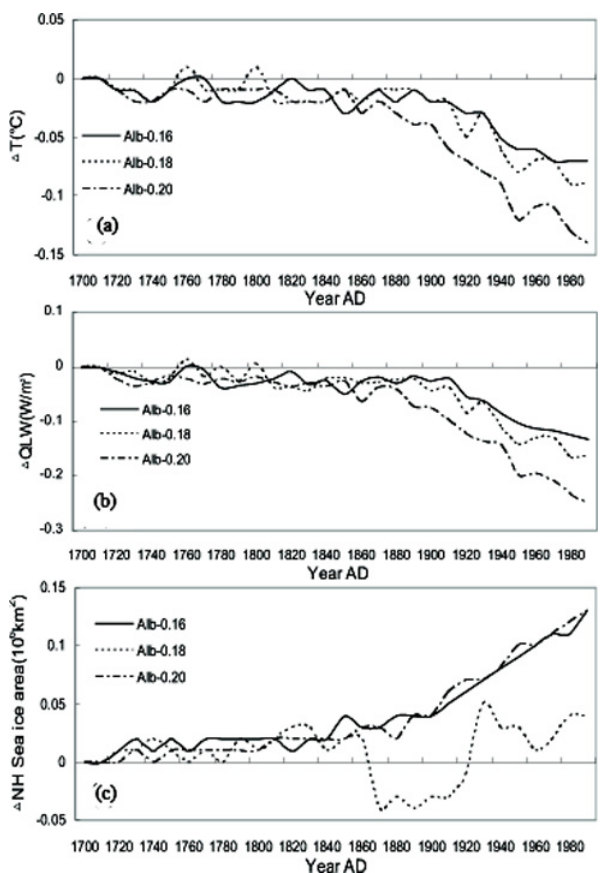
Fig. 2. Changes in (a) annual mean global temperature ( ◦ C); (b) outgoing long-wave radiation (QLW) (Wm − 2 ); (c) sea ice area for NH (10 6 km 2 ), for simulation